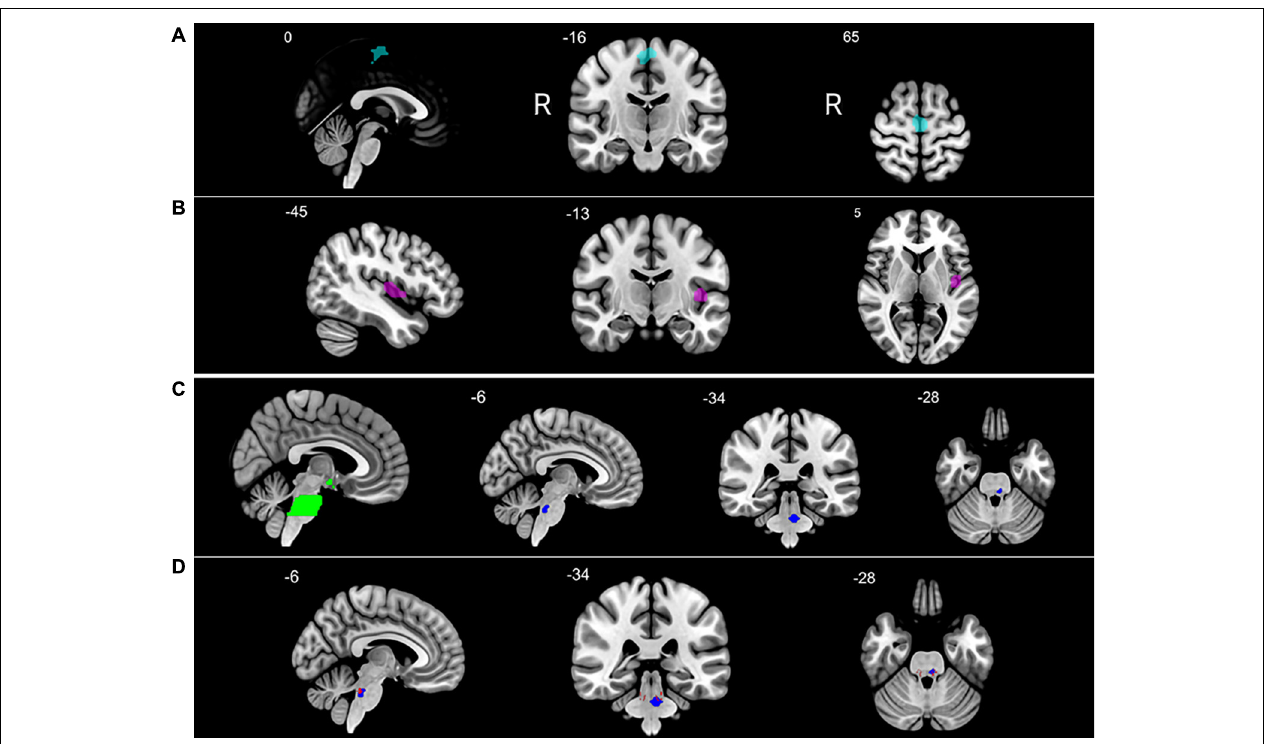
FIGURE 1 | Brain regions showing altered activation after autogenic training (AT) course completion. After AT vs. before AT: (A) increased activation of left medial frontal gyrus [supplementary motor area (SMA)] in the control group to fearful emotional stimuli as compared with migraine patients; (B) increased activation of the left insula in migraineurs to happy emotional stimuli as compared with healthy controls; (C) region of interest (ROI) analysis in migraine-related regions in the migraine subsample: pons and hypothalamus ROI (green), decreased activation in the left pons of migraineurs to fearful emotional stimuli (blue); (D) left pons (blue) overlapping with parabrachial complex (red). Significant clusters are shown at p FWE < 0.05 in Montreal Neurological Institute (MNI) coordinates (R = right side of the brain). TABLE 2 | Brain areas showing different activation changes in healthy controls compared to migraineurs in response to fearful and happy emotional stimuli after autogenic training (AT) completion. Cluster size Cluster p FWE Region Peak coordinates Peak F -value x y